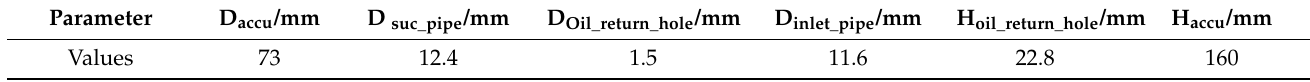
Table 1. Structural parameters of the accumulator.